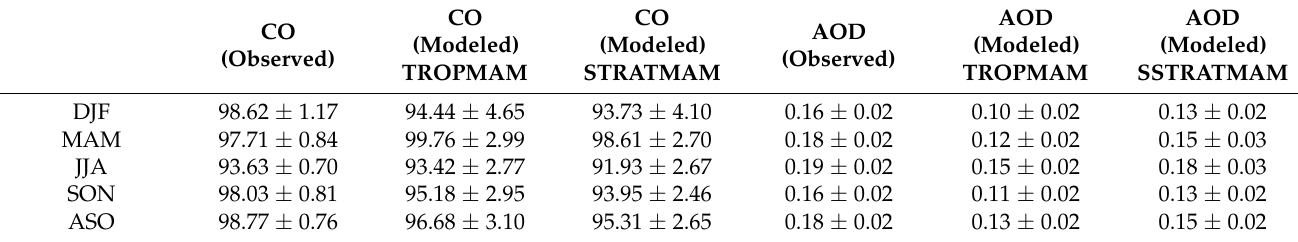
Table 3. Global Annual means and standard deviations for CO (ppbv) and AOD observed from MOPITT and MODIS (Terra and Aqua), respectively, and for CO and AOD by the CAM5-MAM3 model with tropospheric chemistry and tropospheric/stratospheric chemistry mechanisms for the period from 2010 to